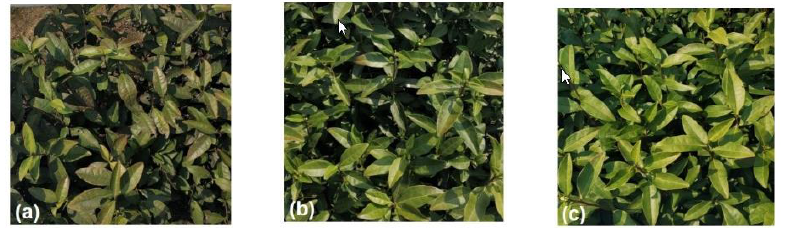
Figure 1. Examples of tea plant growth status in the study area (poor growth ( a ), medium growth ( b ), and good growth ( c ), respectively).